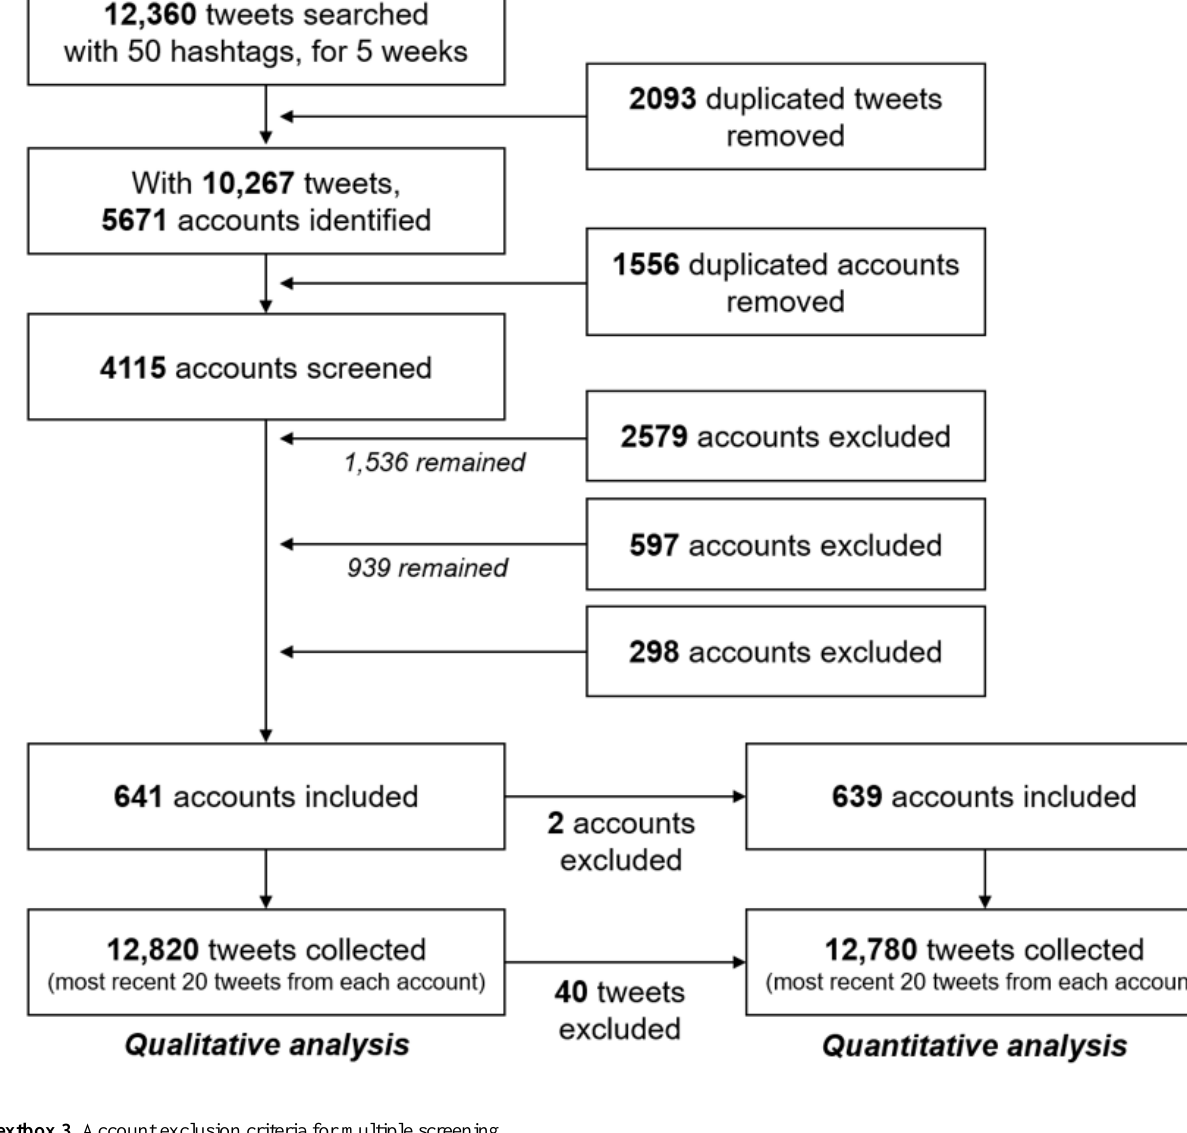
Figure 1. A flow diagram to depict data mining and sampling procedures. PA: physician assistant; PT: physical